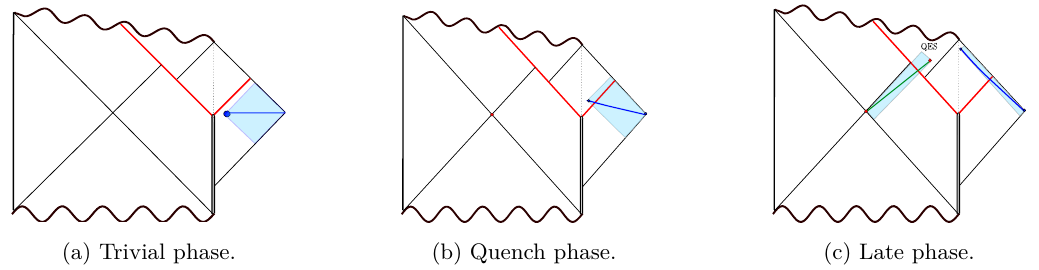
Figure 7. A sketch of the entanglement wedges for the different phases of the entanglement entropy for semi-infinite intervals without QM L .